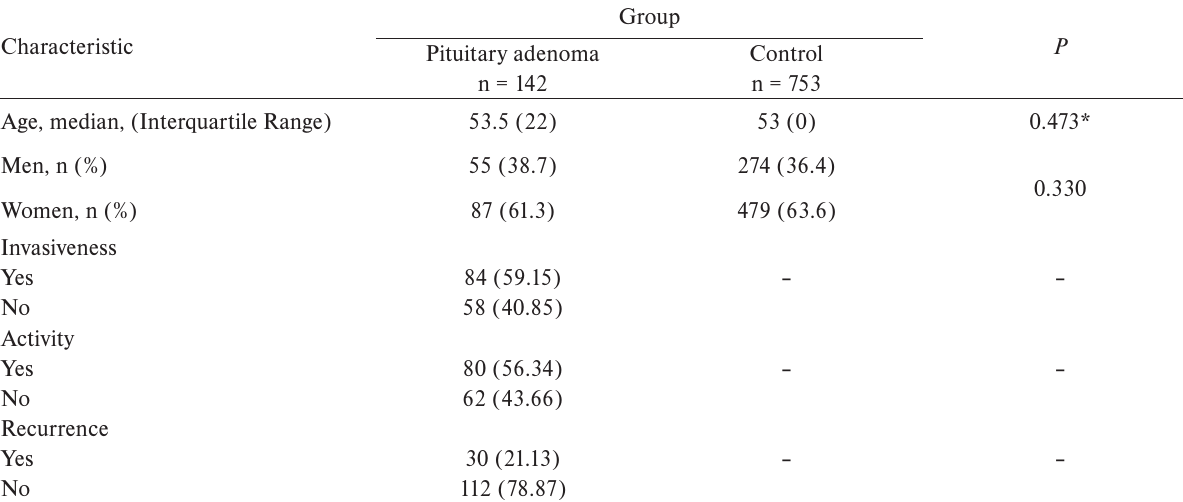
Table 1. Demographic data for control and PA